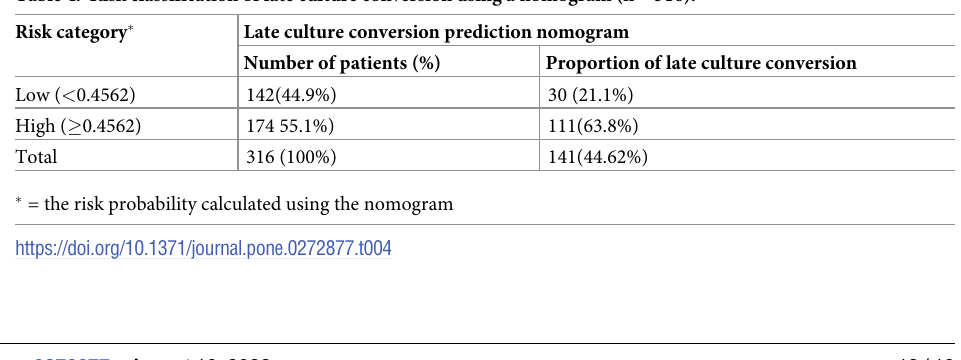
Table 4. Risk classification of late culture conversion using a nomogram (n =